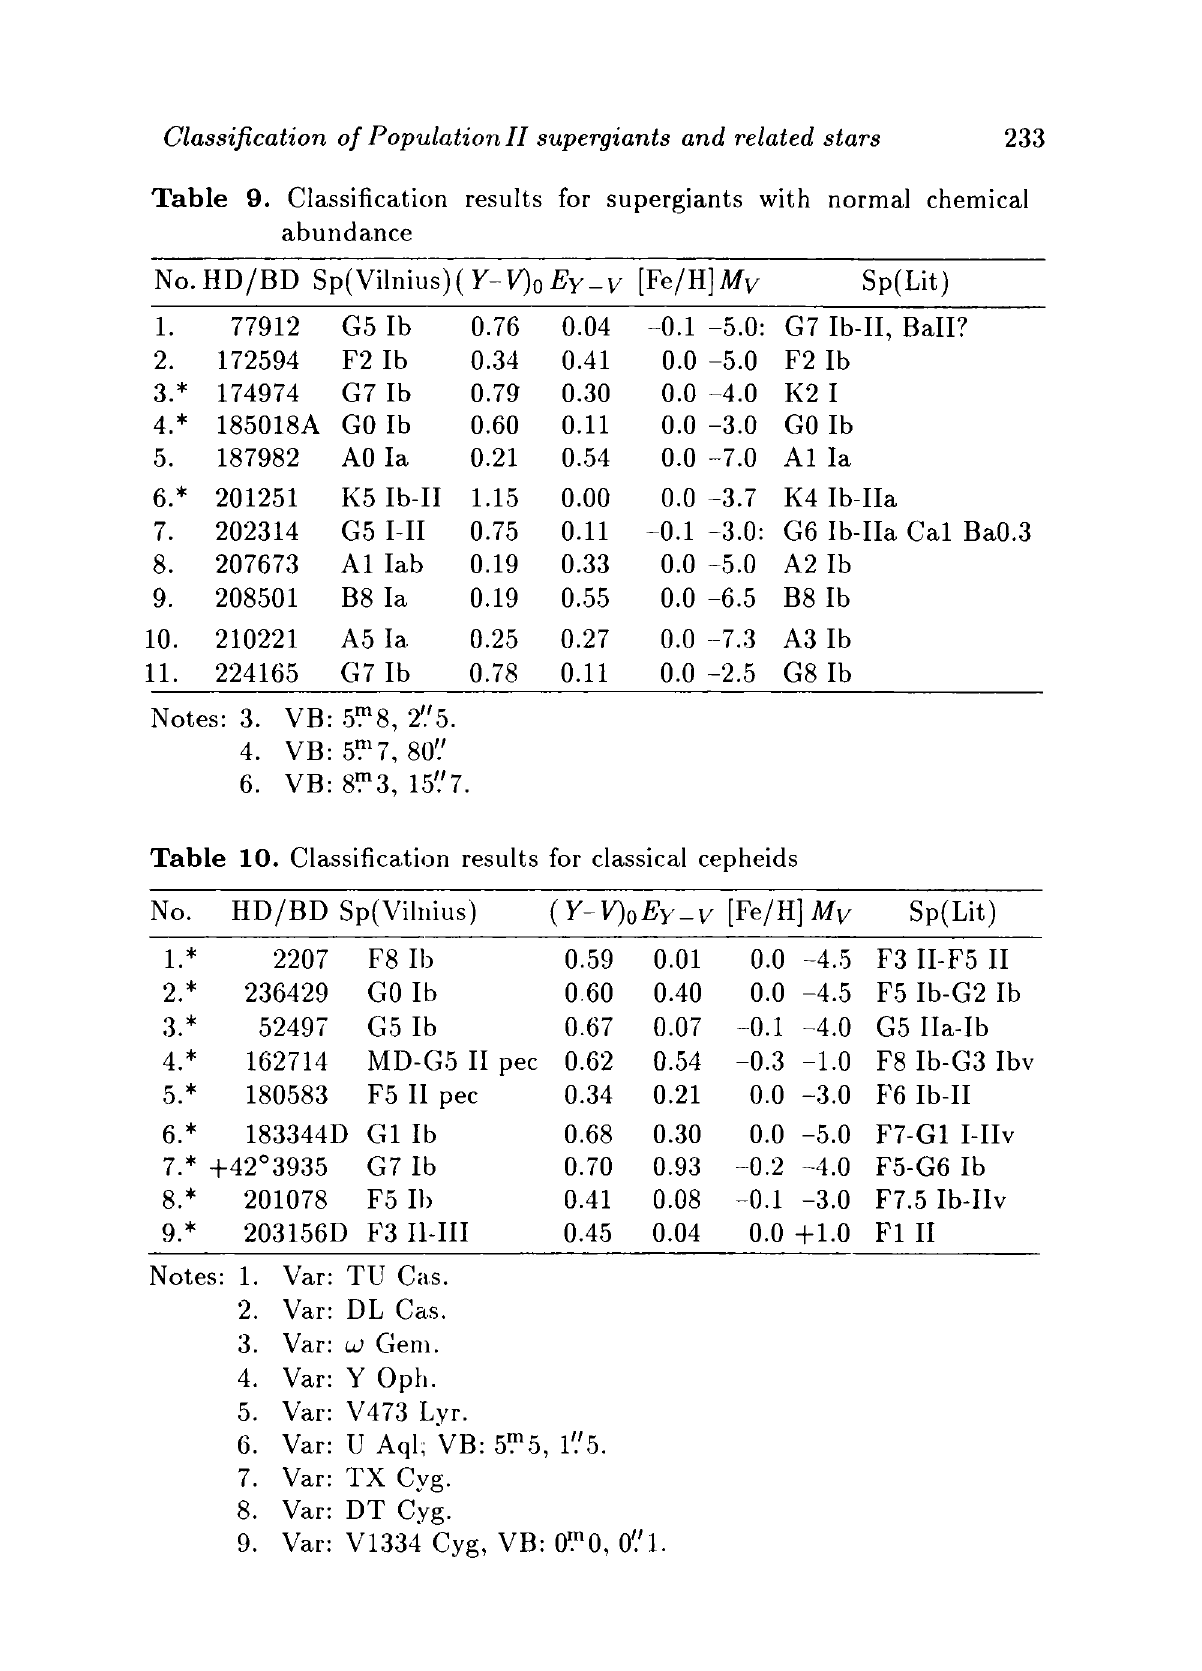
Table 10. Classification results for classical cepheids